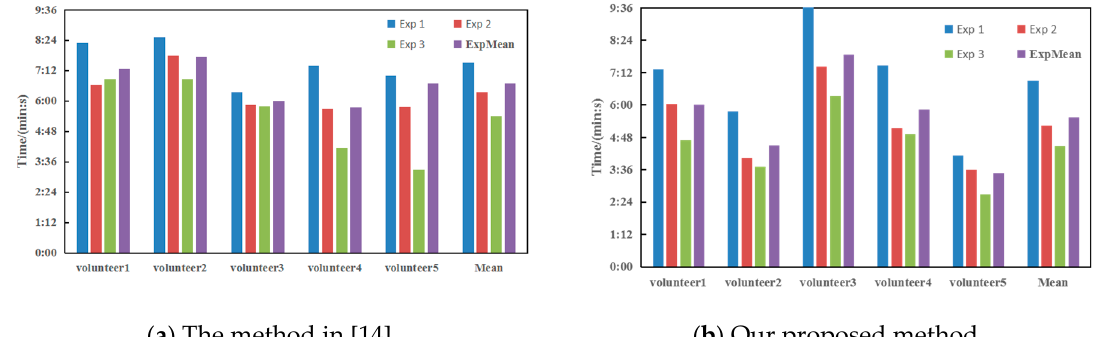
Figure 12. Time consumption comparison between ( a ) the user guidance method in [14] and ( b ) the proposed method. The purple column represents the average value of three repeated experiments.